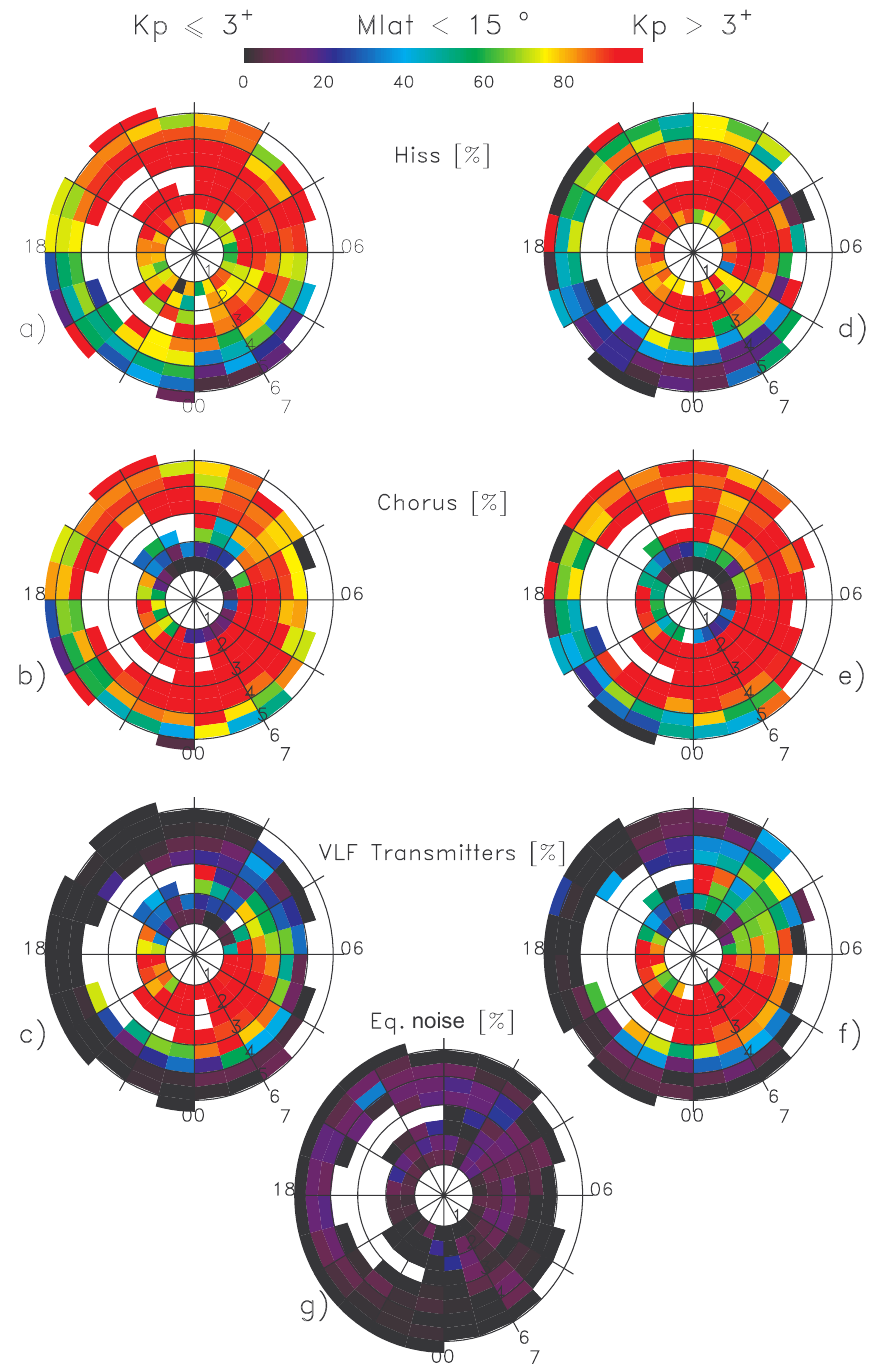
Fig. 6. Probability of observing types of emission for weak (left panels) and strong magnetic activity (right panels). From top to bottom: (a) and (d) Plasmaspheric hiss, (b) and (e) Chorus, (c) and (f) VLF transmitters and (g) Equatorial